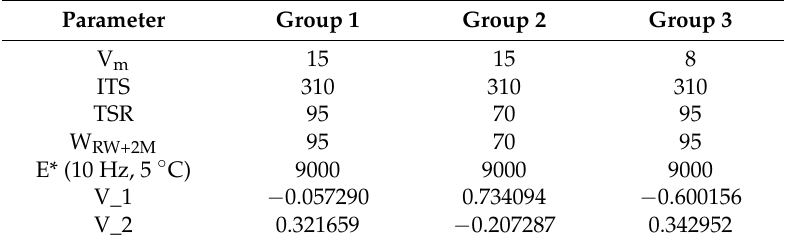
Table 9. Projection coordinates of mineral–cement–emulsion (MCE) mixtures based on maximized discriminant